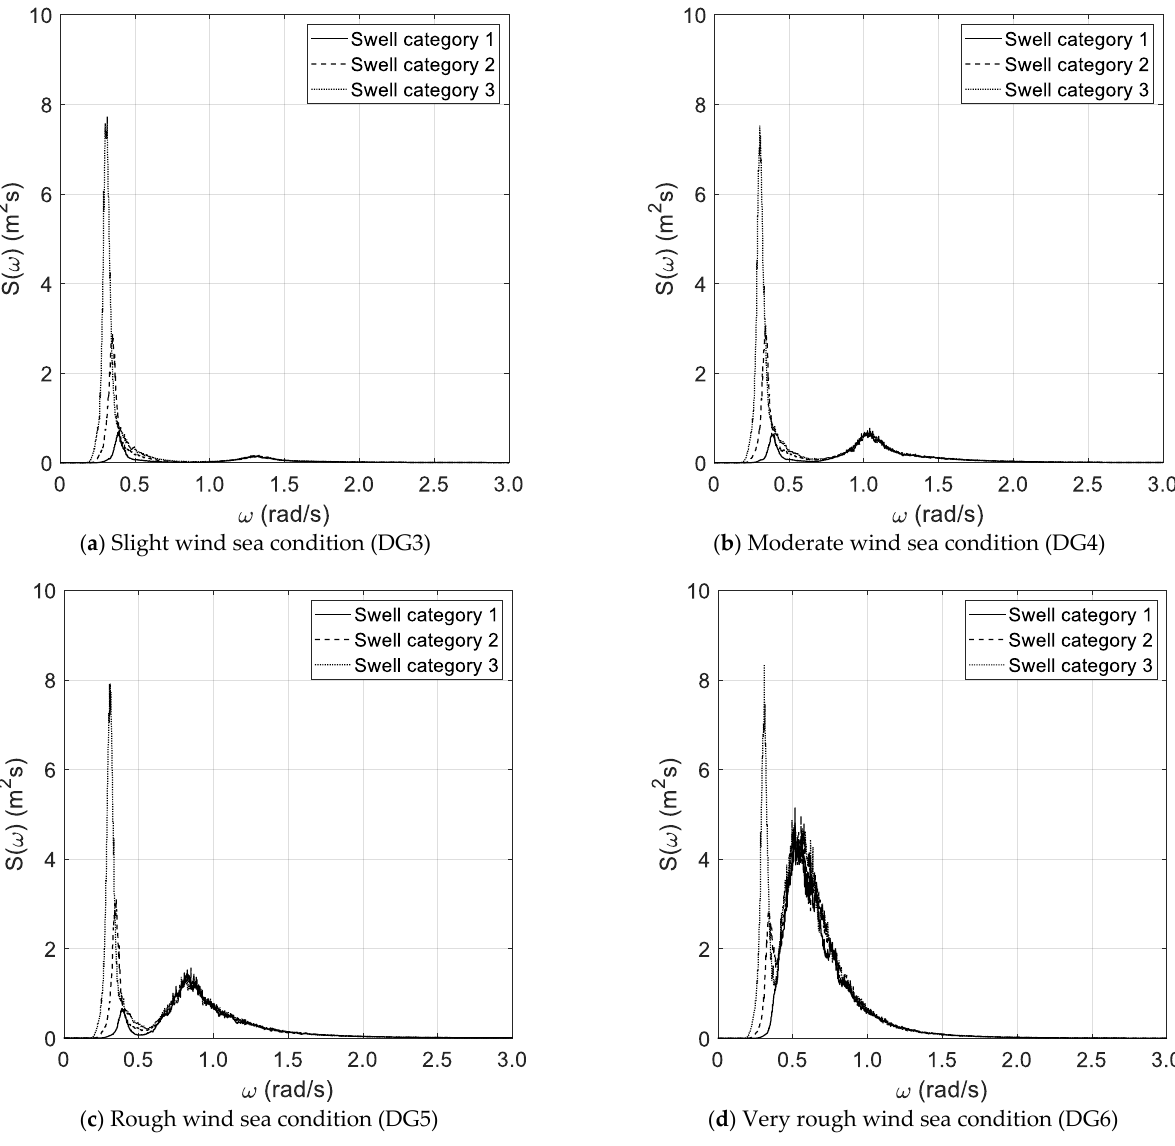
Figure 2. Spectral analysis (Thomson)—long duration.